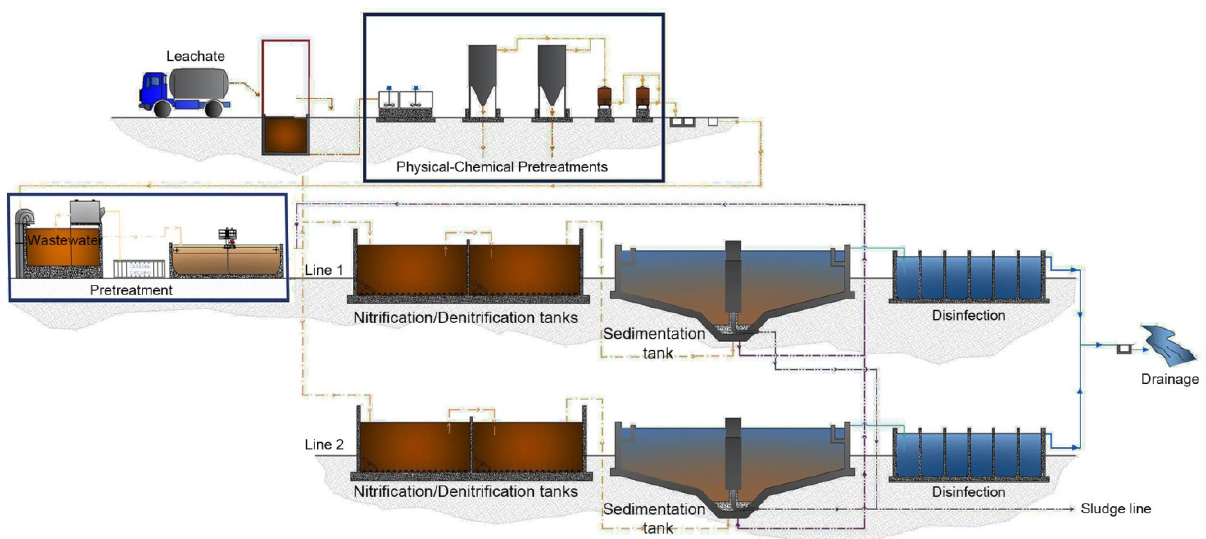
Figure 1. Flow chart of Porto Sant’Elpidio WWTP. A detailed description of the WWTP is provided in Section 2.1 .